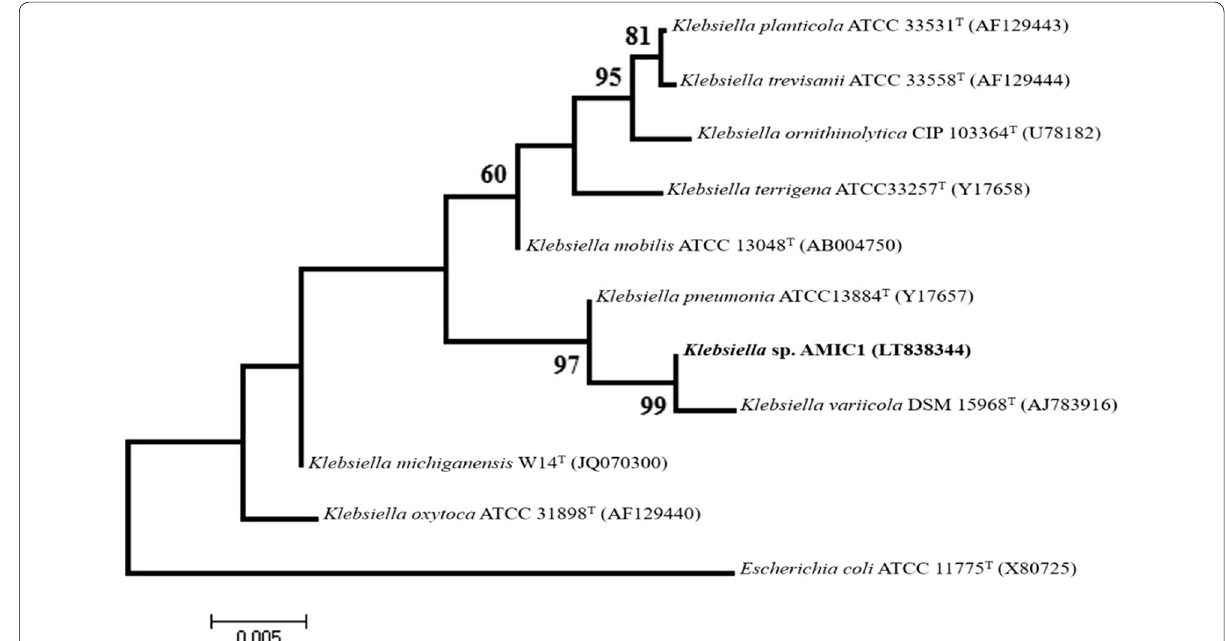
Fig. 1 16S rRNA sequence - based phylogenetic tree of Klebsiella variicola isolated from textile effluents